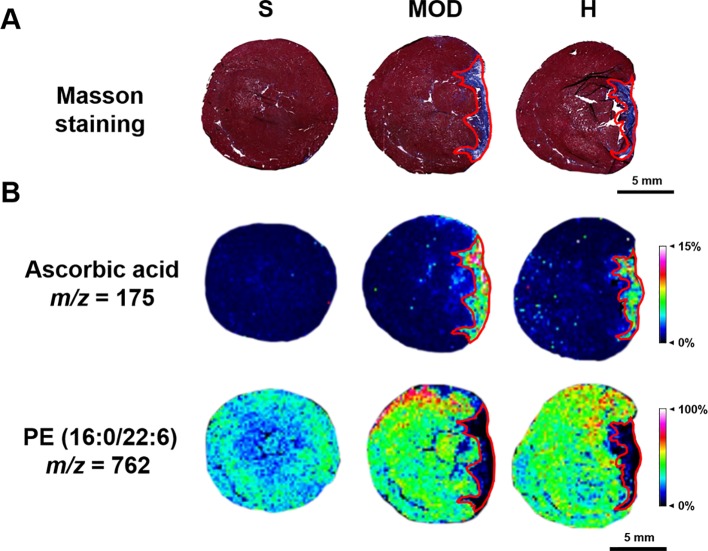
Infarct zone of the matrix-assisted laser desorption/ionization–mass spectrometry imaging (MALDI–MSI) results (marked with red coils). (A) Masson staining of the adjacent heart slice. (B) The MALDI-MSI results of ascorbic acid and PE (16:0/22:6). The spatial resolution is 200 μm (scale bar, 5 mm). S, sham; MOD, model; H, 12 ml/kg Shenfu injection.